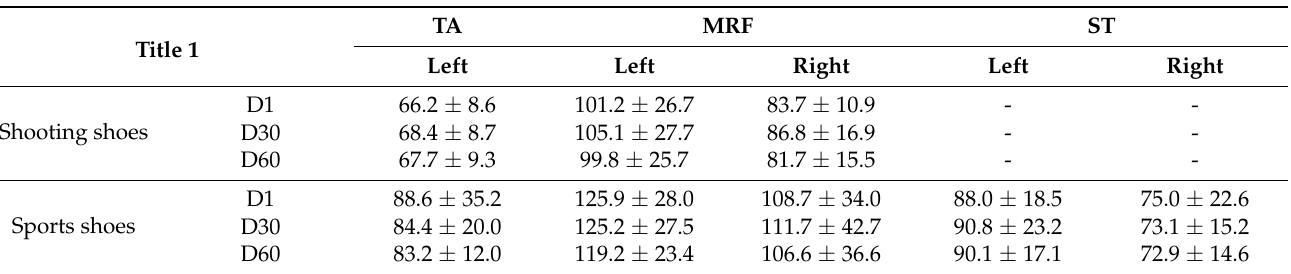
Table 5. A summary of trends in lower extremity muscle median frequency (MDF) during shooting and sports shoe use (Mean ± SD).